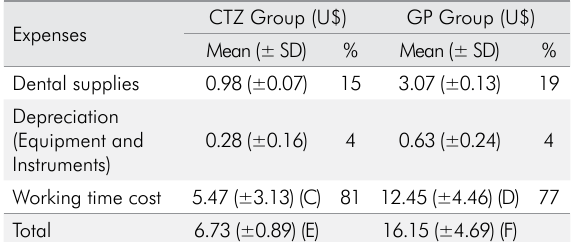
Table 2. Initial sample characteristic. Table 3. Total cost analysis of endodontic treatment performed in the CTZ and GP